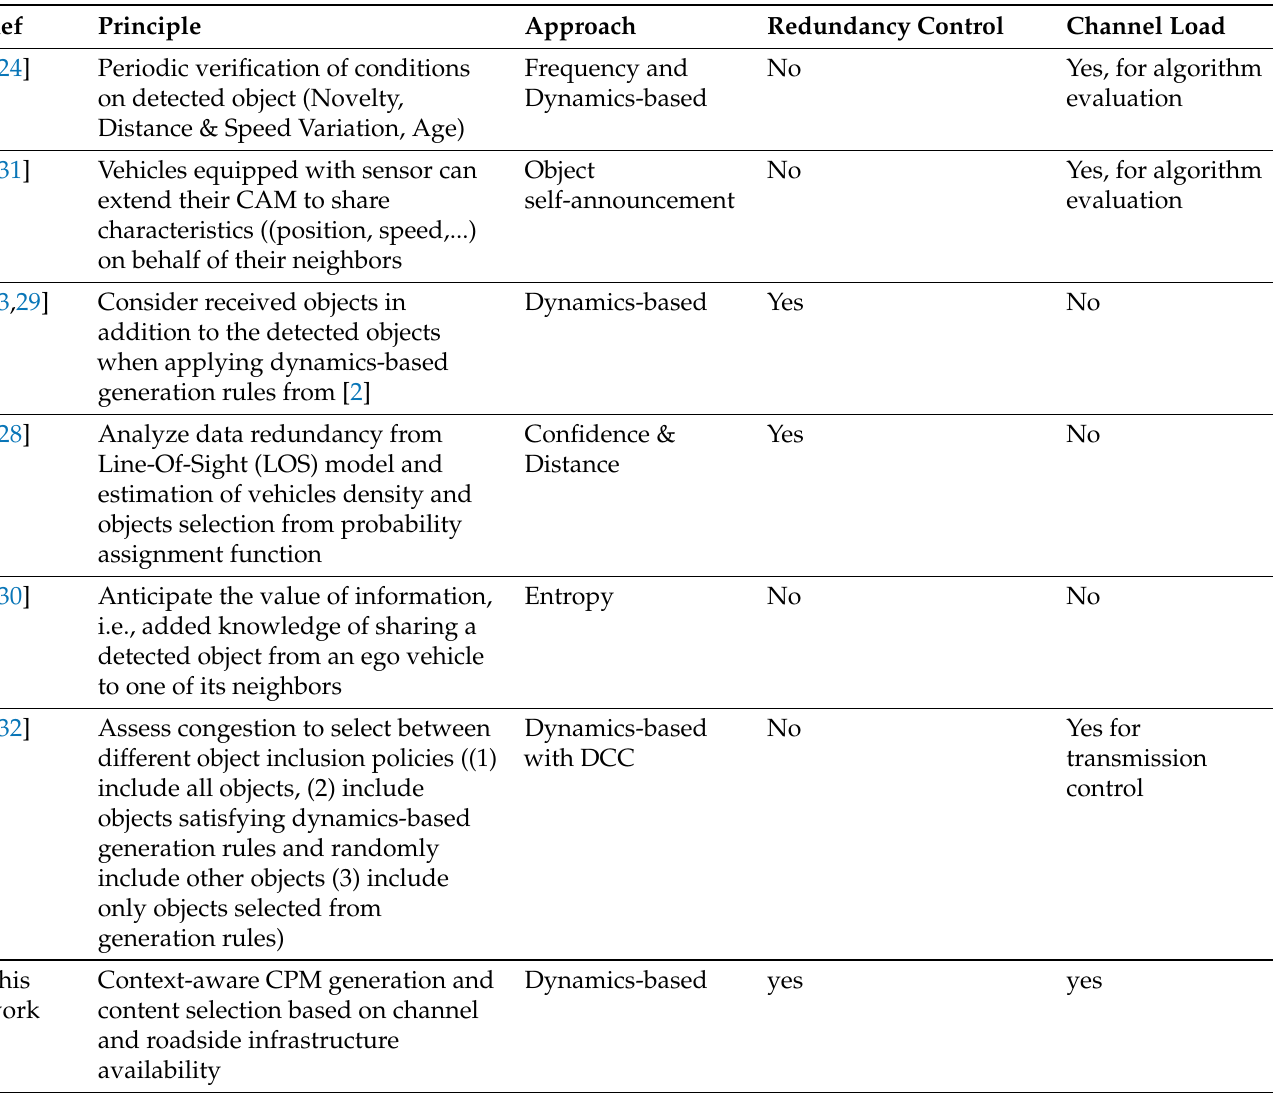
Table 1. Existing CPM data content selection